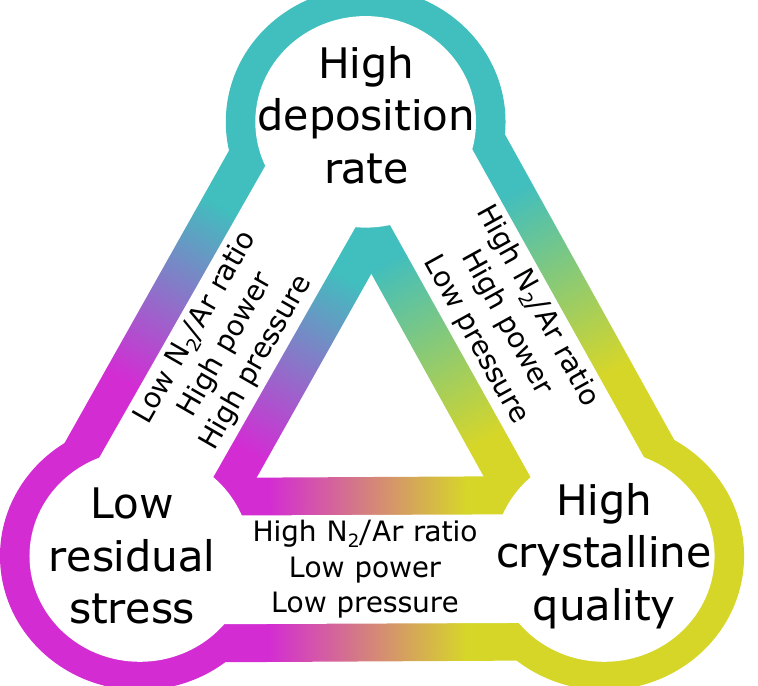
Figure 7. Diagram showing how residual stress, crystalline quality and deposition rate are related to sputtering